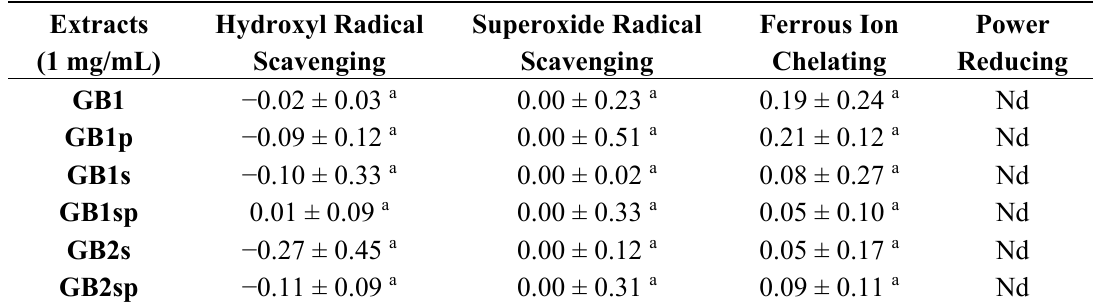
Table 3. Hydroxyl radical scavenging, superoxide radical scavenging, ferrous ion chelating and power reducing of sulfated polysaccharides extractions from the red seaweed, Gracilaria birdiae